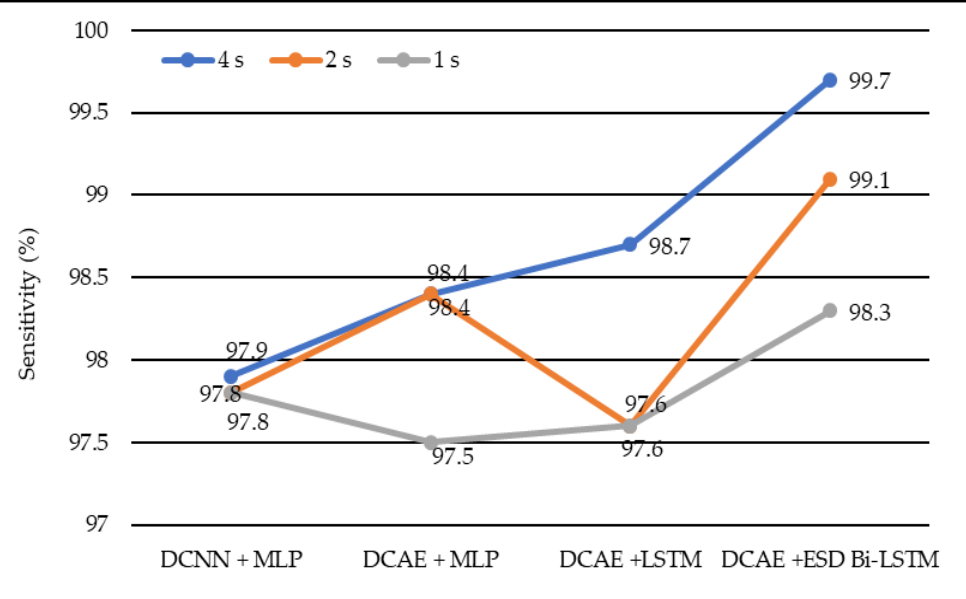
Figure 5. Average sensitivity of different models using different EEG segment lengths.